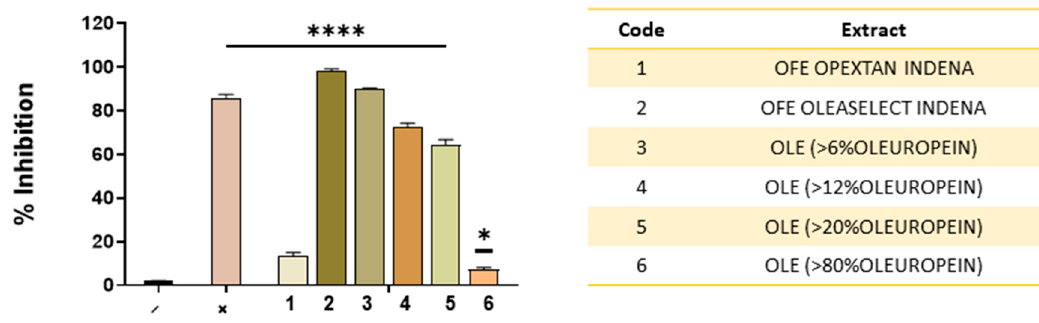
Figure 1. Screening of olive extracts. Co-treatment assay: cells were treated with each extract (200 µ g/mL) and infected with HSV-1 at the same time. Negative control ( − ) indicates infected but non-treated cells, whereas positive control (+) refers to Greco grape cane extract at 10 µ g/mL [7]. Statistical analyses were determined by ANOVA with Dunnett’s test for multiple comparisons. Significances are referred to as the negative control ( − ). **** p < 0.0001; * p <